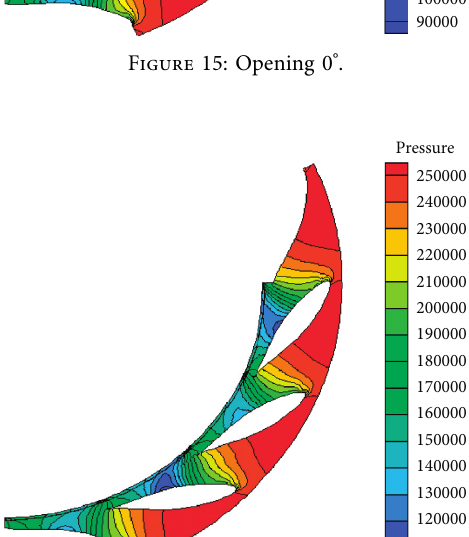
Figure 16: Opening − 3 °